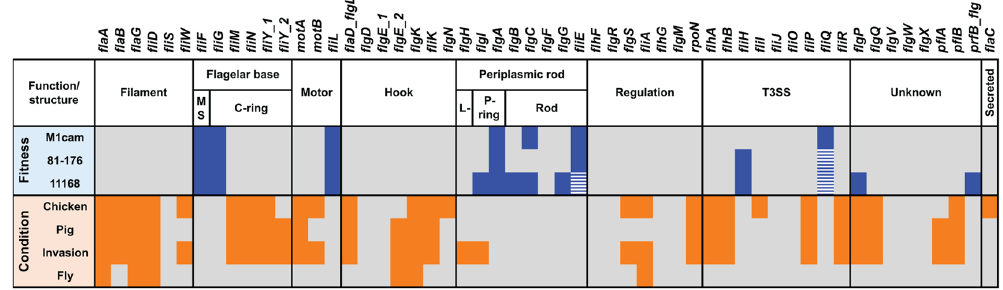
Figure 8. Overview of flagellar system genes required for fitness during in vitro growth and in model representing host interaction. Genes involved in the flagellar system that were required for fitness during in vitro growth of C . jejuni strains M1cam, 81–176 and 11168 are indicated in blue. Genes that passed the fitness score cut-off but did not pass the 0.95 probability for Tn inactivation are indicated with blue dashed boxes.